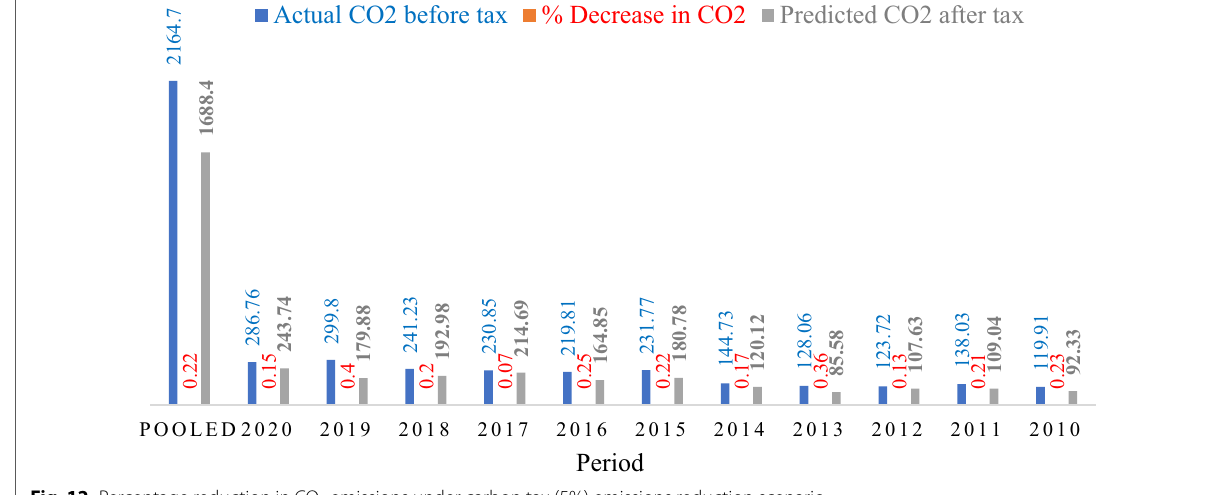
tries (Table 6): Thailand, China, Turkey and Indonesia. The studies indicate that twenty-three emission drivers were considered in the different studies. In Thailand,